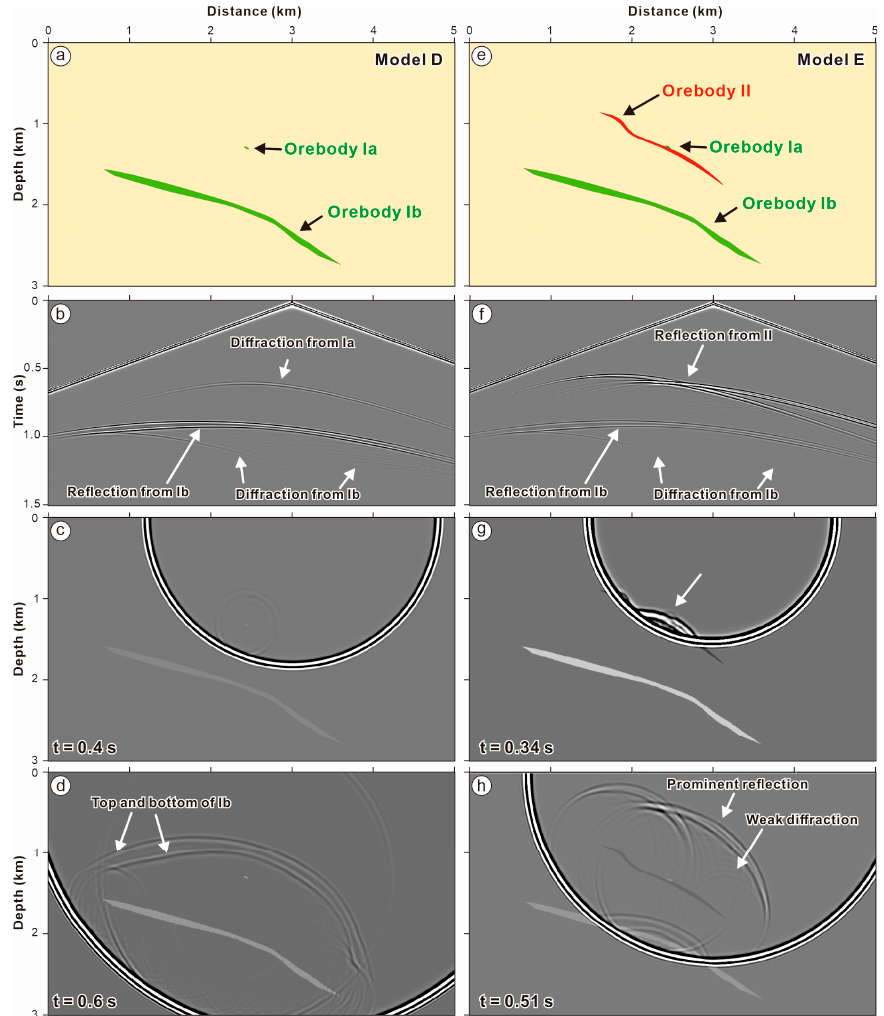
Figure 2. Geological profiles ( a , e ), synthetic seismograms ( b , f ), and snapshots ( c , d , g , h ) of model D and model E. See rock properties in Table 2.